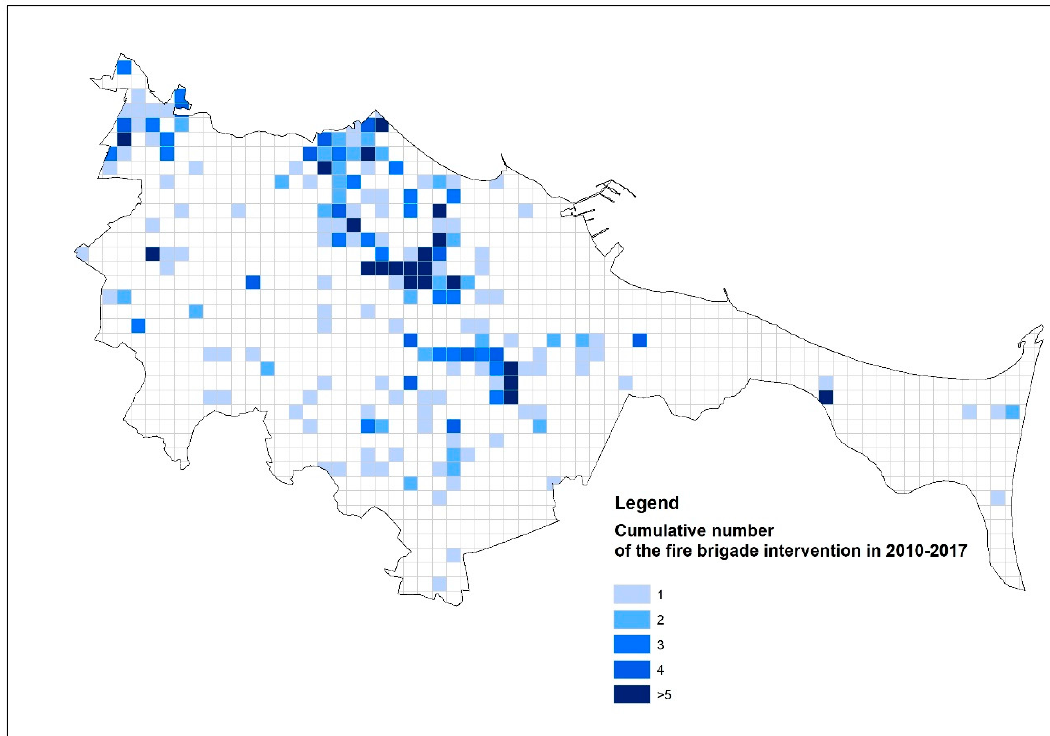
Figure 3. Cumulative number of fire brigade interventions in Gdansk, 2010–2017.